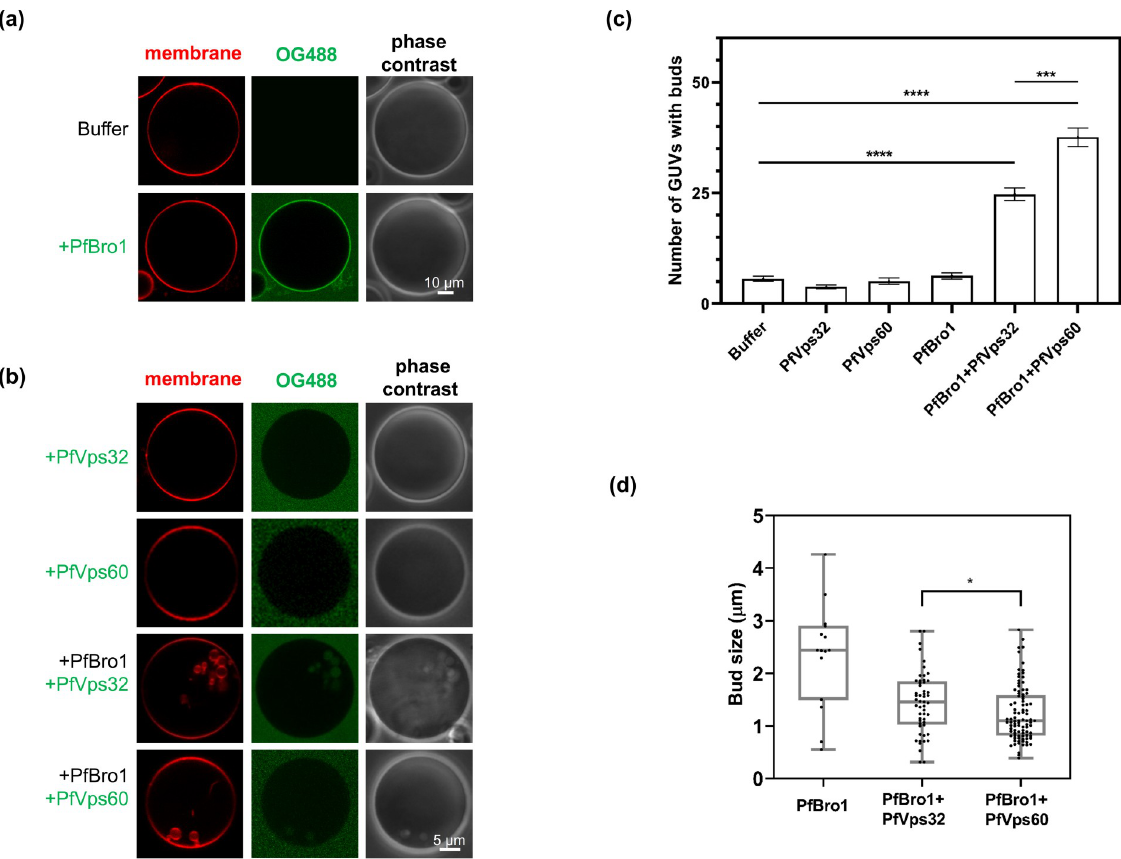
Fig 3. Intraluminal bud formation triggered by ESCRT-III Plasmodium proteins. GUVs composed by POPC:POPS (80:20), labeled with DiI C18 and diluted 1:2 in 2 × protein buffer were incubated with (a) 600 nM PfBro1-OG488 with a 1:3 ratio of labeled and unlabeled protein, or (b) 1200 nM of either PfVps32 or PfVps60 labeled with OG488 (1:3 labeled:unlabeled) alone or in combination with 600 nM PfBro1 and visualized by fluorescence confocal microscopy. (c) Quantification of the number of GUVs with internal buds formed after protein addition. (d) Size of buds formed after the addition of the proteins indicated. Bars represent the mean and standard error of three independent experiments where 50 GUVs of each replicate were observed. p values were determined by Student’s t-test. � : p < 0.05, ��� : p < 0.001, ���� : p <